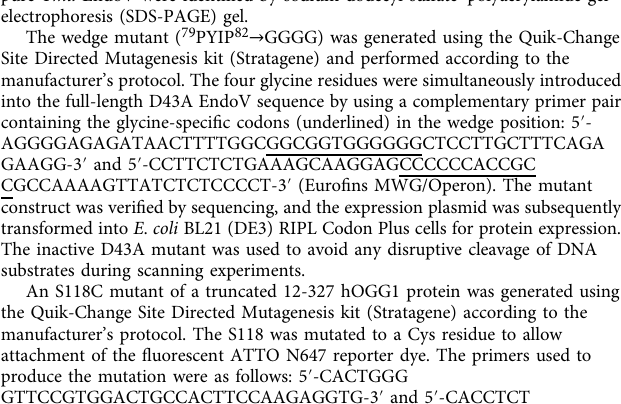
Fig. 1b, a 12kbp linear fragment of λ -DNA with biotin and digoxigenin tags at each end was designed. This DNA substrate was prepared by PCR ampli fi cation of λ - DNA using primers modi fi ed with 5 ′ biotin (5 ′ -bio-ACTTCGCCTTCTTCC CATTT-3 ′ ) and 5 ′ digoxigenin (5 ′ -dig-ATCTCGCTTTCCACTCCAGA-3 ′ ) (Euro fi ns MWG/Operon). The PCR reaction was performed in a 1× LongAmp Taq Reaction Buffer, with a fi nal volume of 50 μ l, 300 µM of each dNTP, 0.4µM of each primer, 2 units LongAmp Taq DNA polymerase (New England Biolabs) and 0.1ng µl − 1 of λ -DNA template. The PCR included an initial denaturation step at 94 °C for 3min, 35 cycles of denaturation (94 °C for 15 s), annealing (60 °C for 60 s) and primer extension (65 °C for 16min), followed by a fi nal extension step at 65°C for